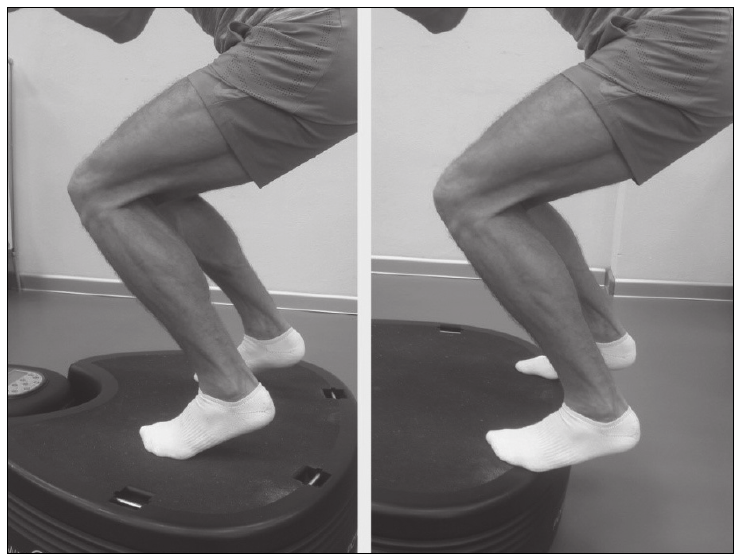
Figure 1. Two squat positions during WBV (modified from Gojanovic, Feihl, Liaudet, Gremion, & Waeber,